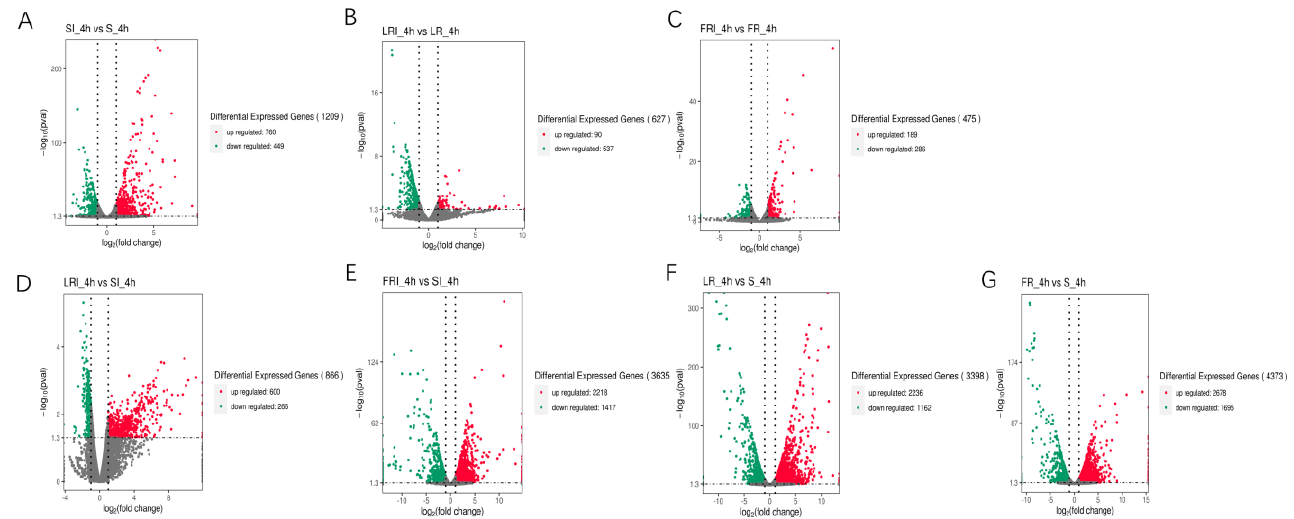
Figure 3. Volcano plot of the DEGs in a comparison between SI_4h vs. S_4h ( A ), LRI_4h vs. LR_4h ( B ), FRI_4h vs. FR_4h ( C ), LRI_4h vs. SI_4h ( D ), FRI_4h vs. SI_4h ( E ), LR_4h vs. S_4h ( F ), and FR_4h vs. S_4h ( G ). The X-axis indicates log 2 (fold change) of the DEGs between each of two samples. The Y-axis indicates the − log 10 (corrected p value) of the gene expression variations, and the corrected p value was applied to assess the statistical significance of the change in the unigene expression. The up-regulated, down-regulated, and unchanged unigenes are dotted in red, green, and grey, respec- tively.